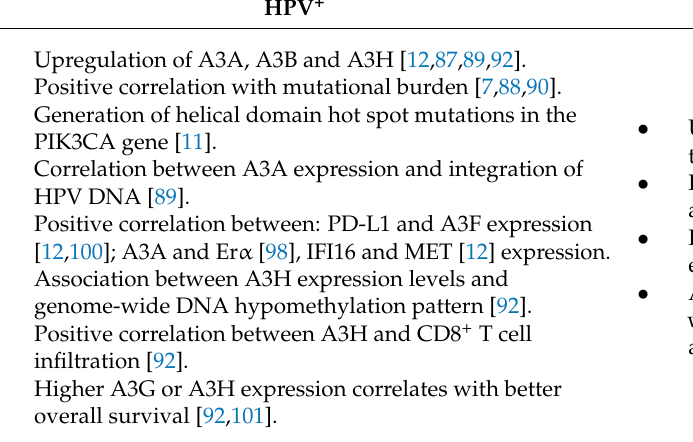
Table 1. Main features and role of APOBEC in HPV + and HPV - head and neck squamous cell carcinoma (HNSCC). HPV + HPV